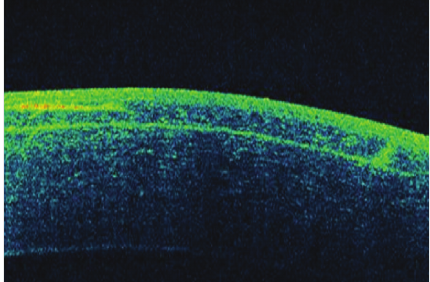
Figure 4: OCT image of both flaps in the temporal quadrant showing theabrupt endoftheprimarycutdonewith themechanical